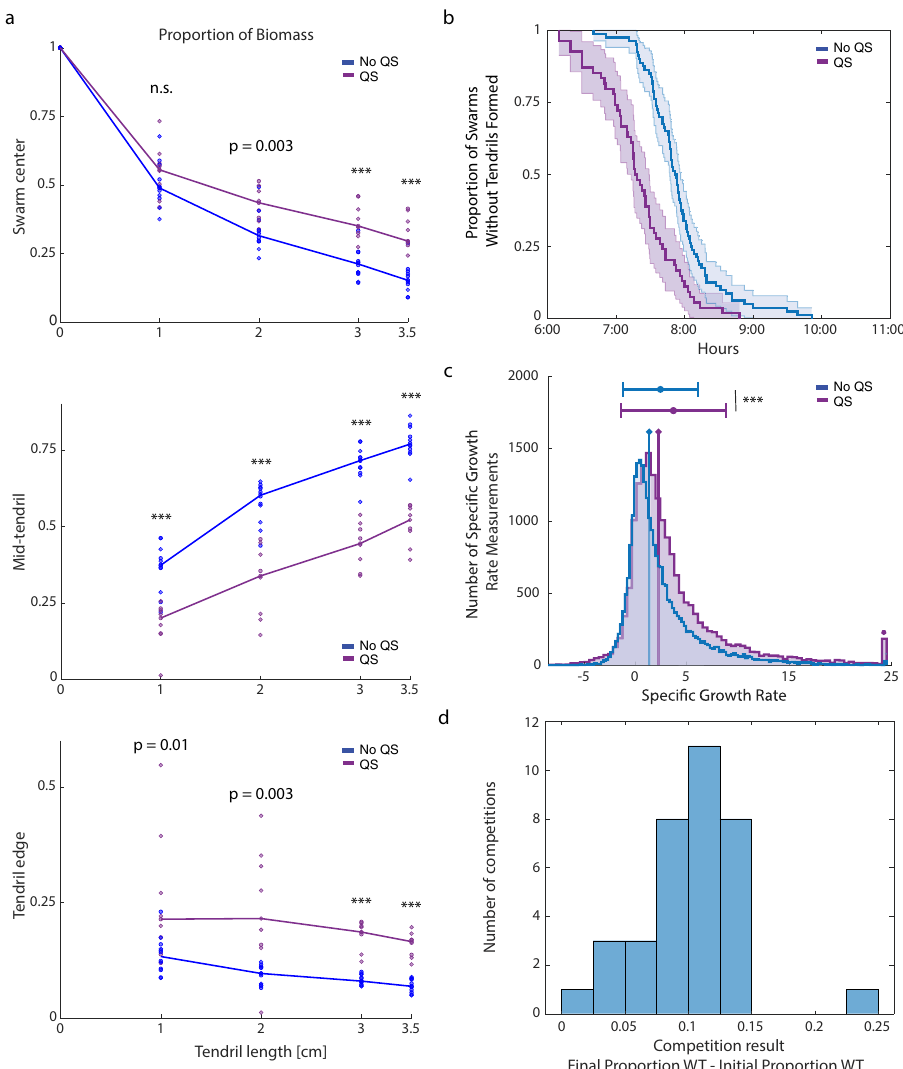
Fig. 5 Quorum signal perturbation reveals accelerated tendril formation, biomass redistribution, and no competitive disadvantage. a Proportion of all tendril biomass along tendril length localized to the indicated regions of a swarm tendril de fi ned graphically in Fig. 4c: Swarm center (top), mid-tendril region (middle), and tendril edge (bottom). The tendril edge is de fi ned as the outermost 4.5 mm of a swarming tendril relative to the swarm center. All statistical comparisons performed with the two-sided rank-sum test. *** indicates a p -value < 0.001. Results where the null hypothesis was not rejected are indicated by n.s. b Swarming start times with or without autoinducer in the plate media. c Speci fi c growth rate in the tendril tip (outermost 0.86 mm of swarming tendril) in swarms without (left) and with (right) quorum signals provided. The two distributions were compared using the two-sided rank-sum test, p -value < 2.22e − 16. Stem plot indicates distribution median. Mean and standard deviation indicated above histogram. Histogram bar with (*) contains all points with speci fi c growth rate greater than maximum x -axis value. d Competition results for WT PA14 against the Δ rhlA strain in 1:1 ratio with quorum signals in the plate media (see methods). Data includes three biological replicates with several technical replicates in each. See Supplementary Table